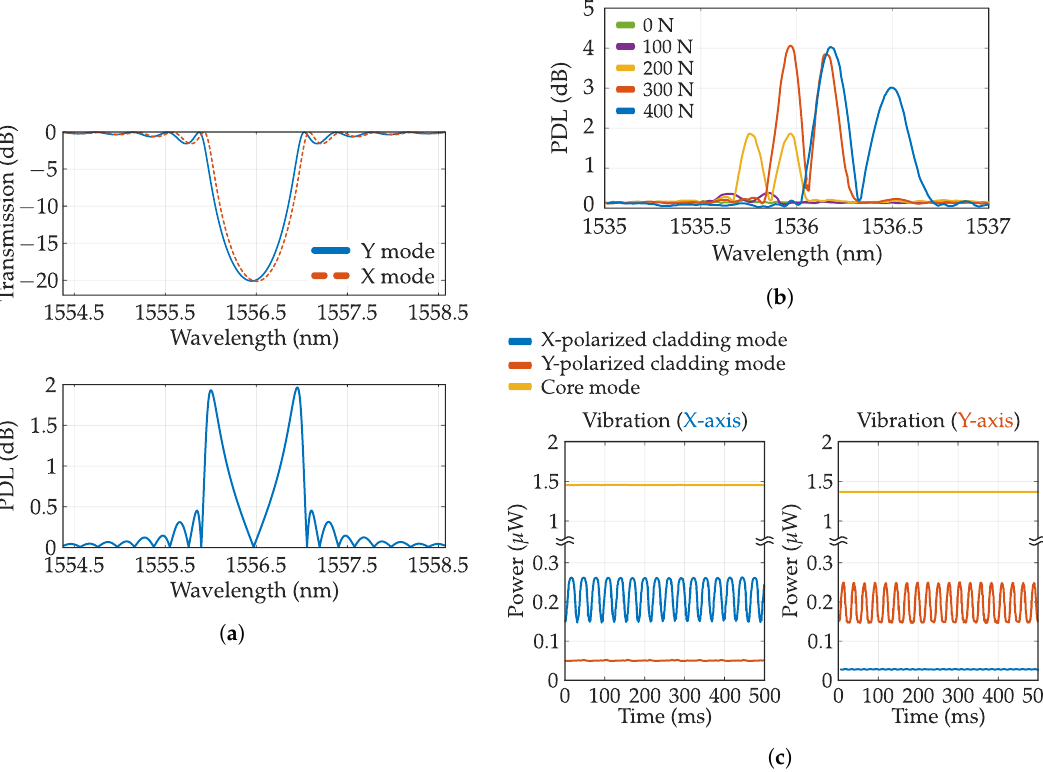
Figure 6. ( a ) Transmission and polarization dependent losses (PDL) spectra for a uniform FBG (parameters used for the simulation: L = 2 mm, Λ = 538.1 nm, and δ n = 10 − 3 ). ( b ) PDL evolution as function of the transverse force (extracted from [76]). ( c ) Cladding mode amplitude of an FBG written in a PM fiber against time. Vibrations parallel to the polarization state affect cladding mode amplitude while perpendicularly polarized light is insensitive (extracted from